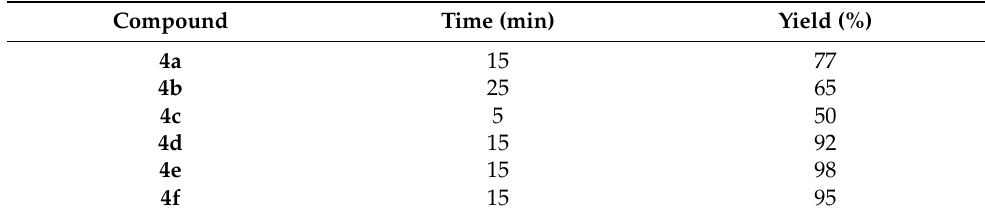
Table 1. Reaction time and yields for the synthesis of compounds 4a – f.